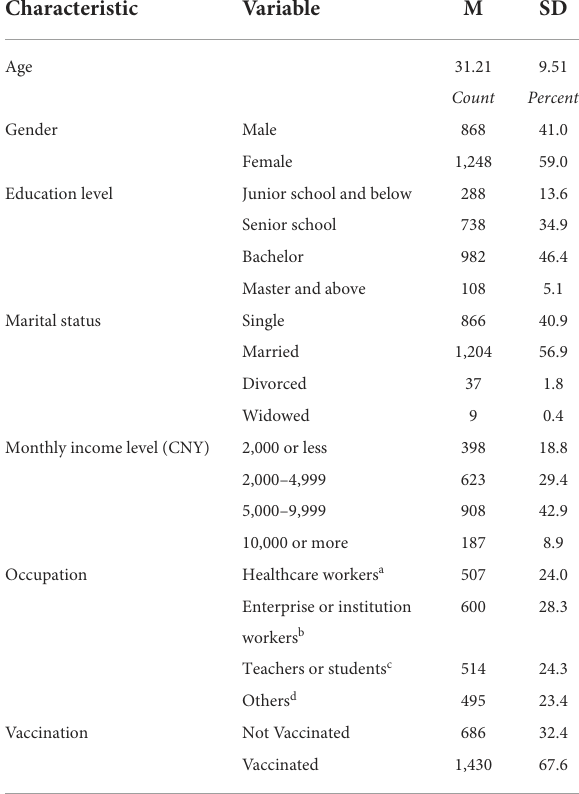
TABLE 1 Sample characteristics ( n =